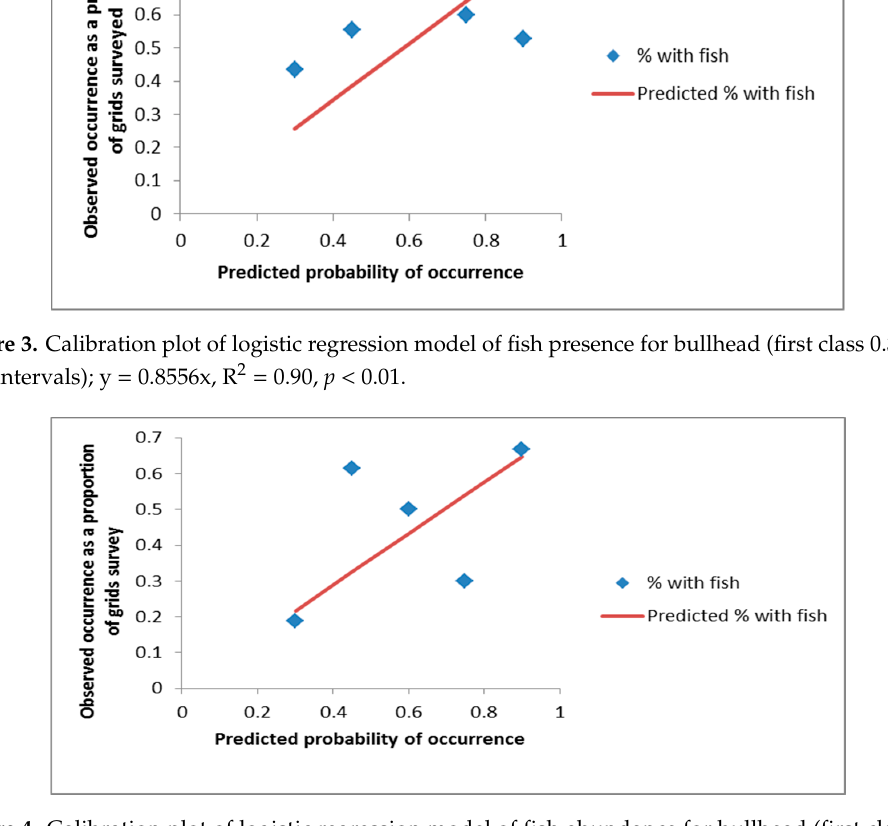
Figure 4. Calibration plot of logistic regression model of fish abundance for bullhead (first class 0.3 with 0.15 intervals); y = 0.7201x, R 2 = 0.88, p < 0.05. Collation of the predictions of the statistical and CHSC models against bullhead presence in grids is shown in Figures 5 and 6.